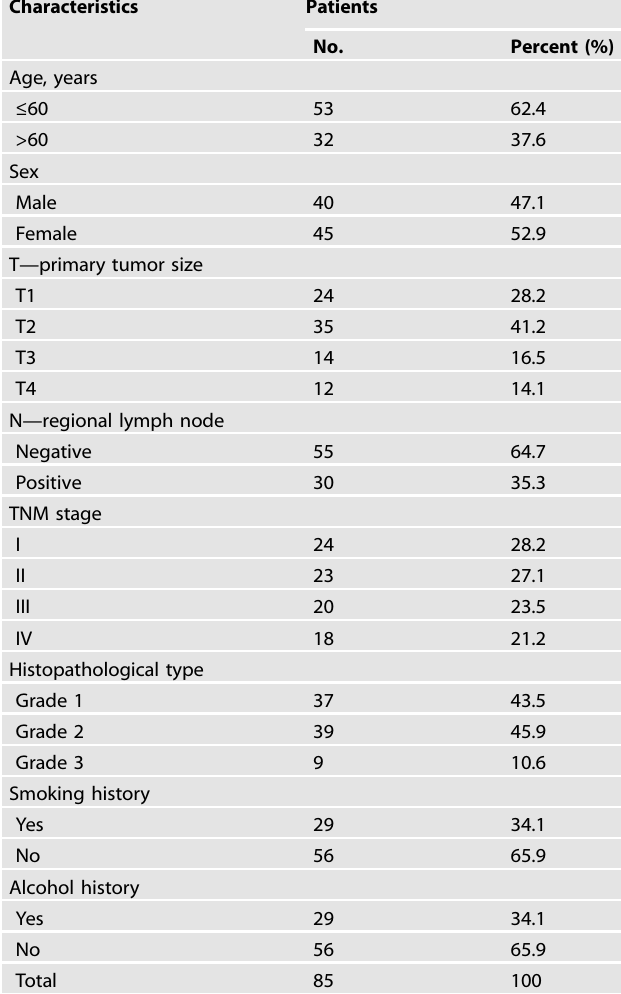
Table 1. Baseline characteristics of HNSCC patients included in the study.